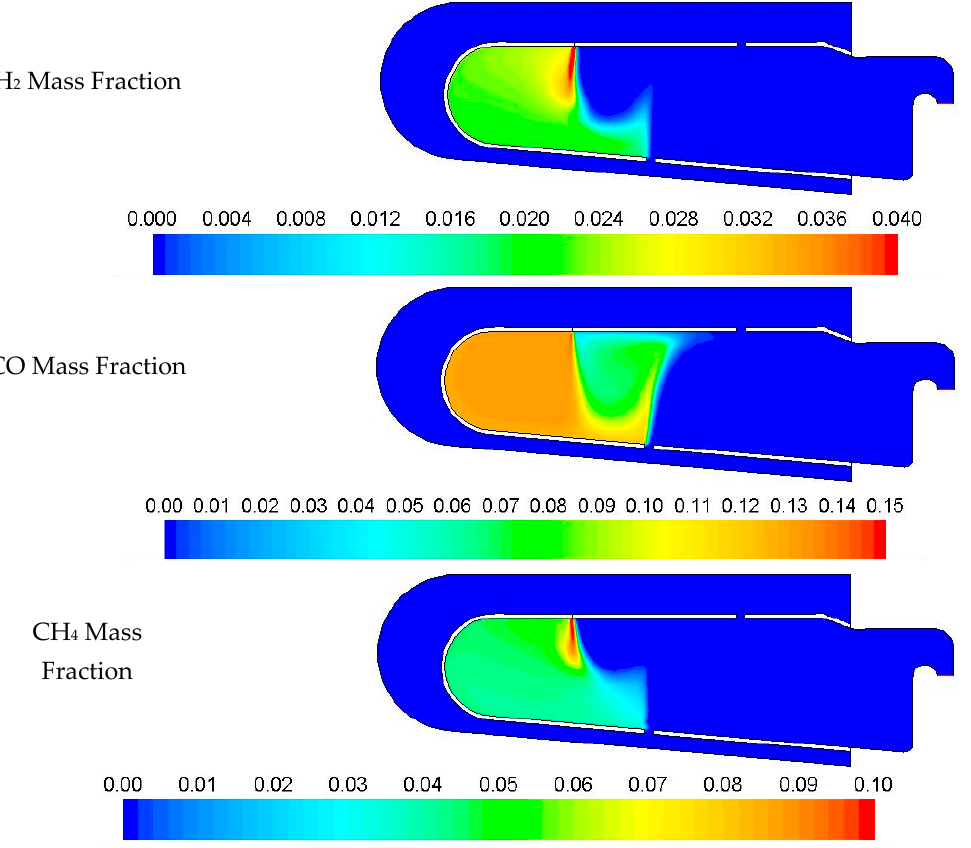
Figure 24. Mass fraction distributions of the main species for each fuel.